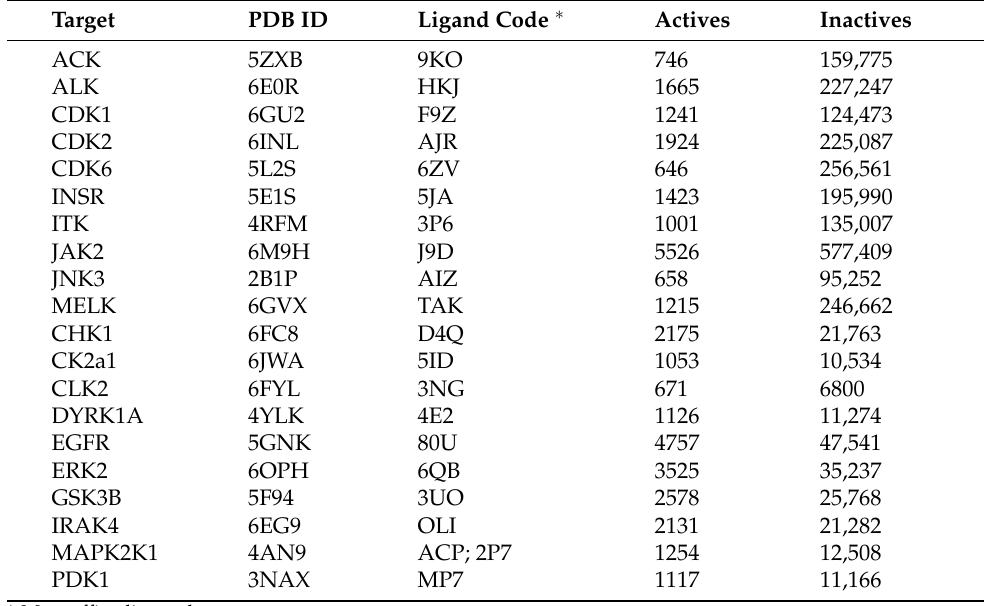
Table 4. A summary of all proteins (active and inactive) obtained from preprocessing